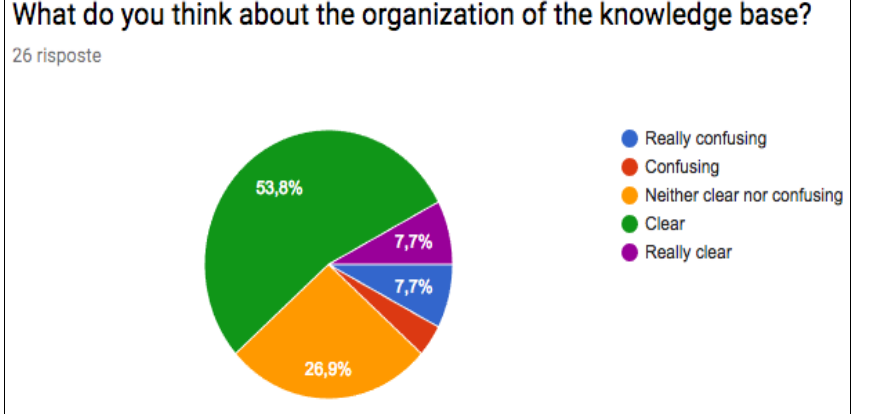
Figure 16. Opinion on the organization of information in the knowledge base